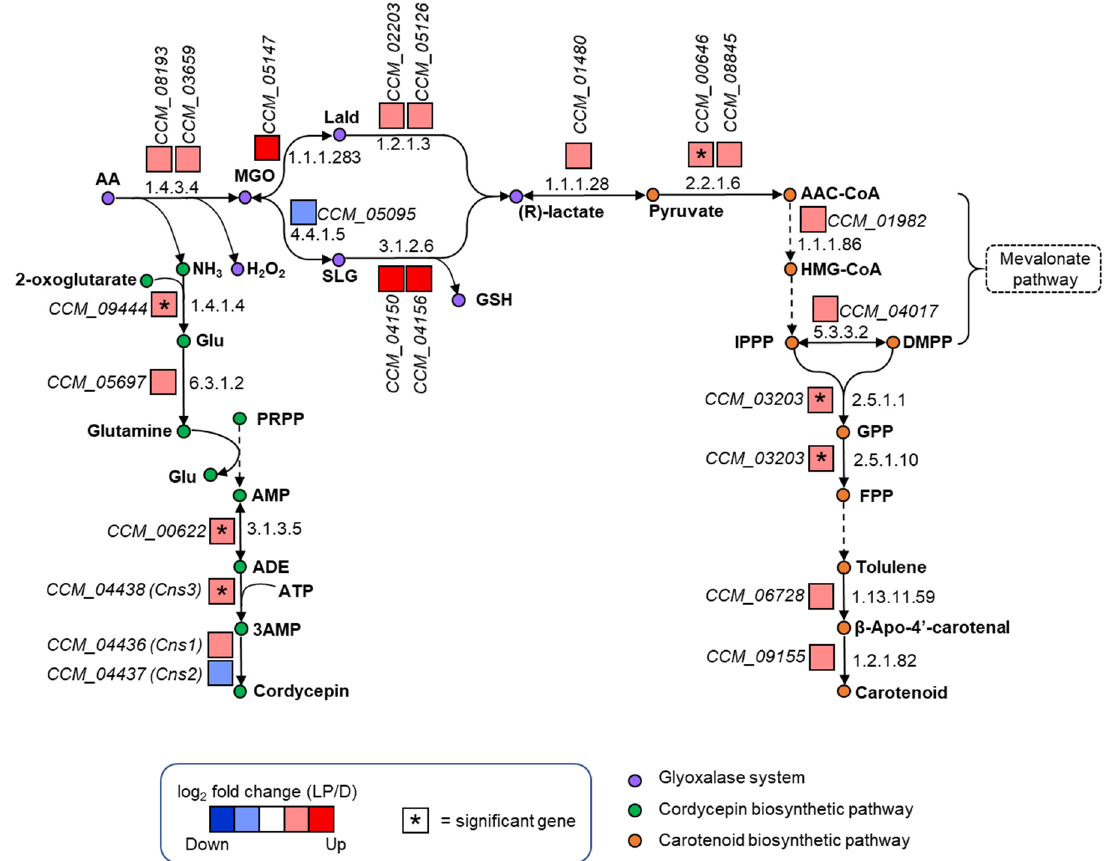
Figure 5. Metabolic responses of C. militaris to the light-programming condition through cordycepin and carotenoid biosynthetic pathways. Abbreviations: AA, aminoacetone; MGO, methylglyoxal; NH 3 , ammonia; H 2 O 2 , hydrogen peroxide; Lald, lactaldehyde; SLG, S-lactoylglutathione; GSH, glutathione; Glu, Glutamate; PRPP, 5-phospho-alpha-ribose 1-diphosphate; AMP, adenosine-5 (cid:48) -monophosphate; ADE, adenine; ATP, adenosine-5 (cid:48) -triphosphate; 3AMP, adenosine-3 (cid:48) -monophosphate; AAC-CoA, acetoacetyl-CoA; HMG-CoA, 3-hydroxy-3-methylglutaryl-CoA; IPPP, isopentenyl diphosphate; DMPP, dimethylallyl diphosphate; GPP, geranyl diphosphate; FPP, farnesyl diphosphate.